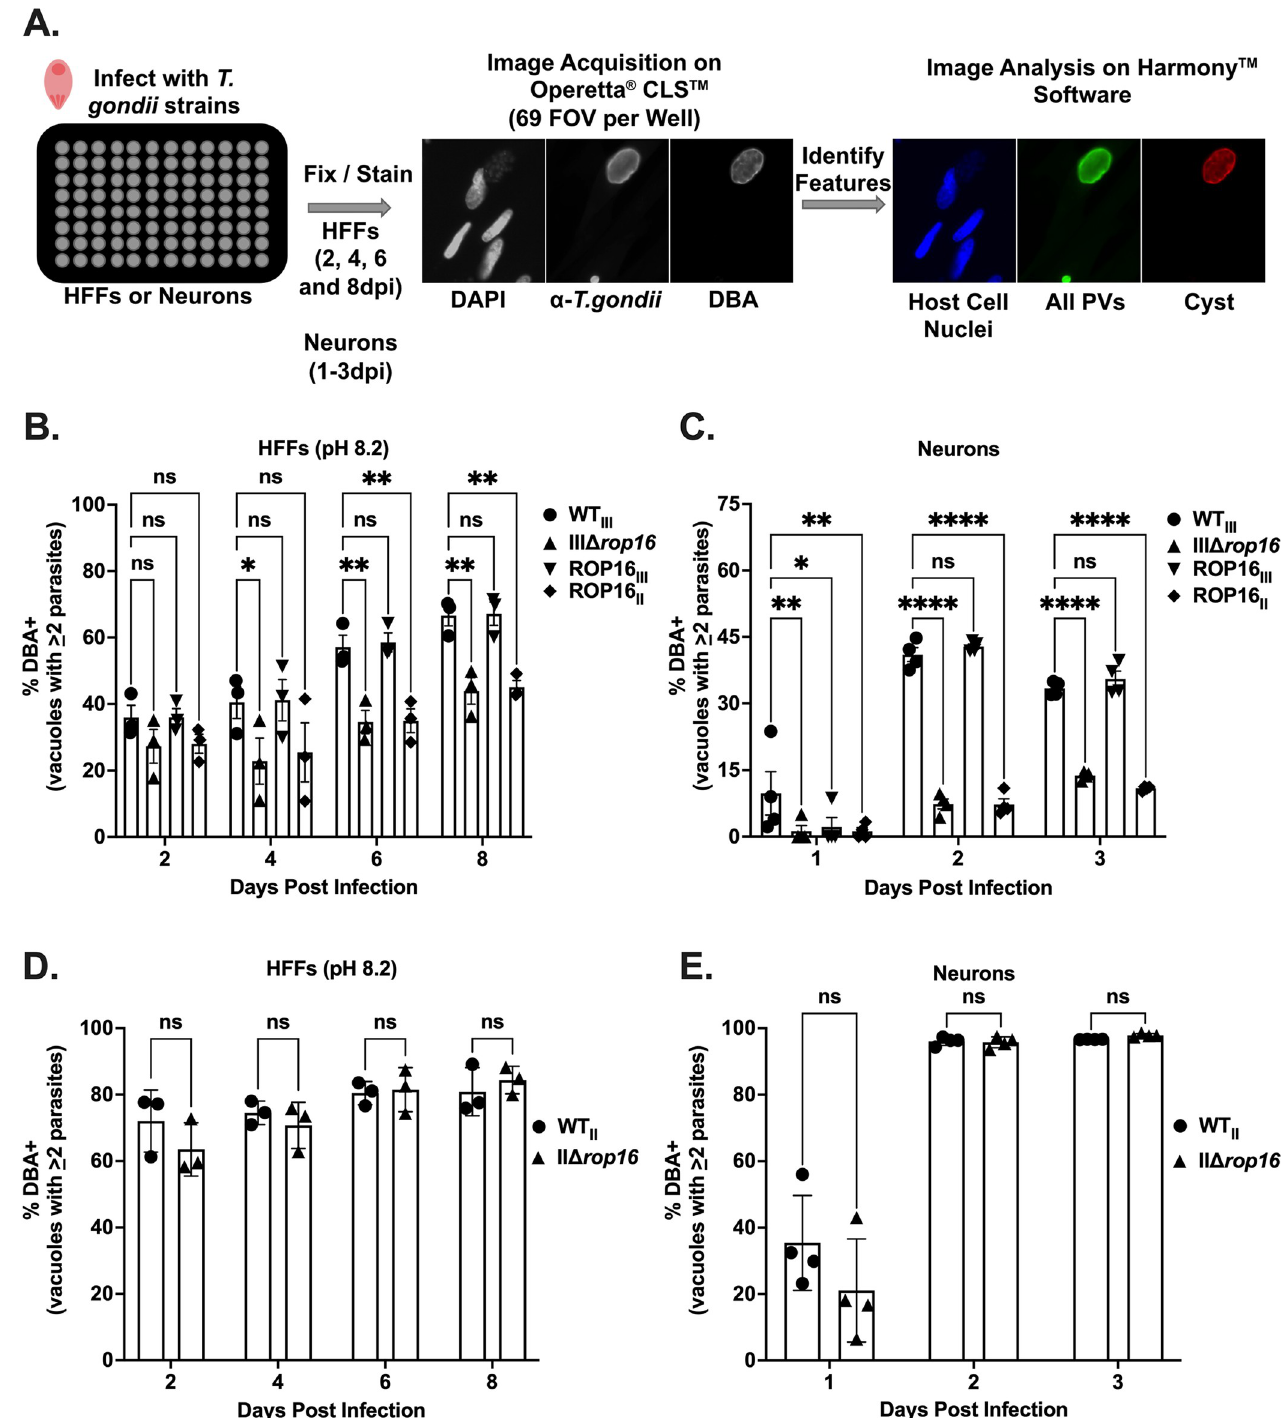
Fig 1. ROP16 III facilitates cyst formation of a type III parasites in multiple models of cyst development. (A) Schematic of automated cyst quantification using Operetta CLS and Harmony software. Parasitophorous vacuoles (PVs) were identified by staining with anti- T . gondii antibody. Cysts were identified by DBA staining. (B) Quantification of encystment of over time in a stress model of encystment for listed type III strains. (C) Quantification of encystment over time as in (B) except in primary neuronal cultures (PNCs). (D) Quantification of encystment over time in stress model of encystment for listed type II parasites. (E) Quantification of encystment over time as in (D) except in PNCs. (B-E) % Cyst = (# of DBA + Vacuoles with � 2 parasites /# of Total Vacuoles with � 2 parasites) * 100. Bars, mean ± SEM. Black dots = Average % cyst for 1 experiment. (B, D) N = 10 wells/experiment, 3 experiments total. (C, E) N = 5 wells/